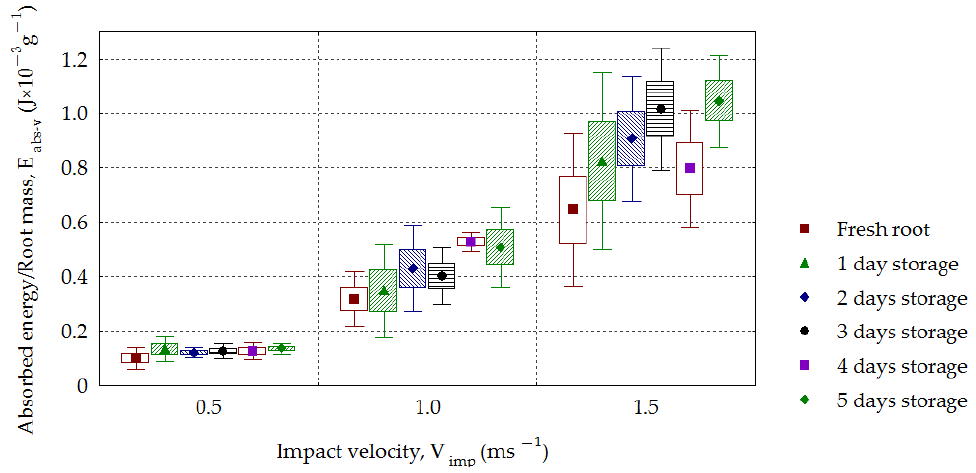
Figure 13. Dependence of the contact volume ( CV ) on the impact velocity ( V imp ) for the stored beets.